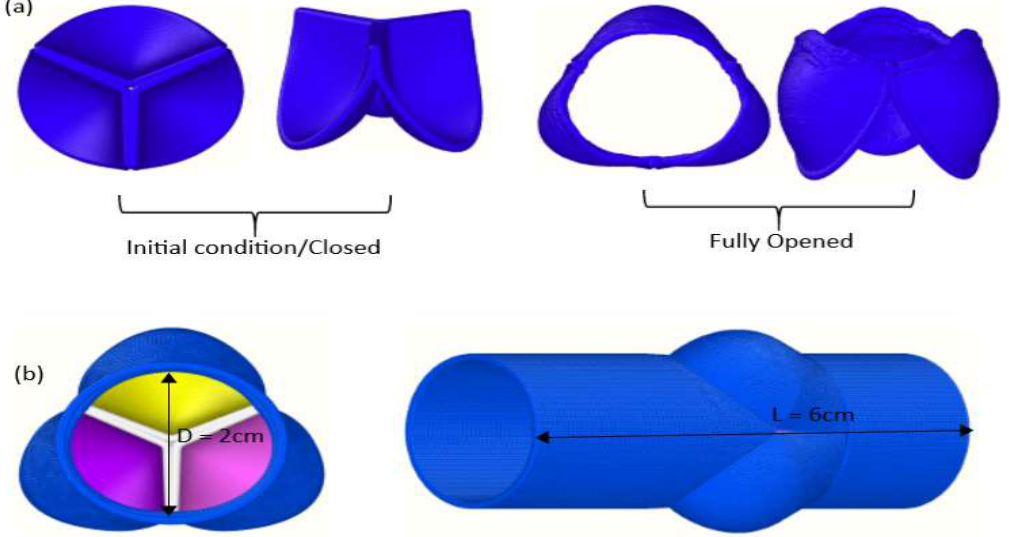
Figure 1. Valve leaflets ( a ) and complete geometry ( b ).